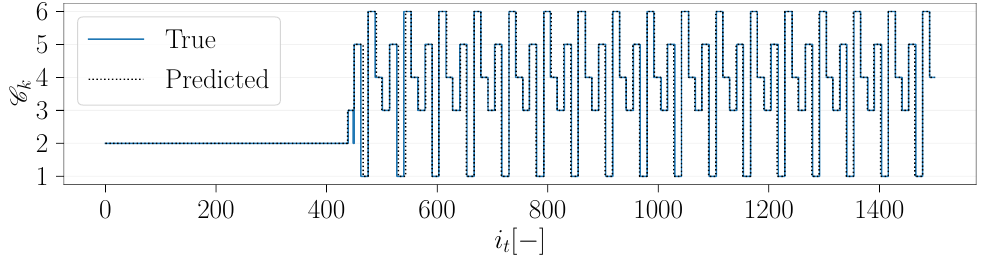
Figure 12. True and predicted cluster assignment over the snapshot index i t .